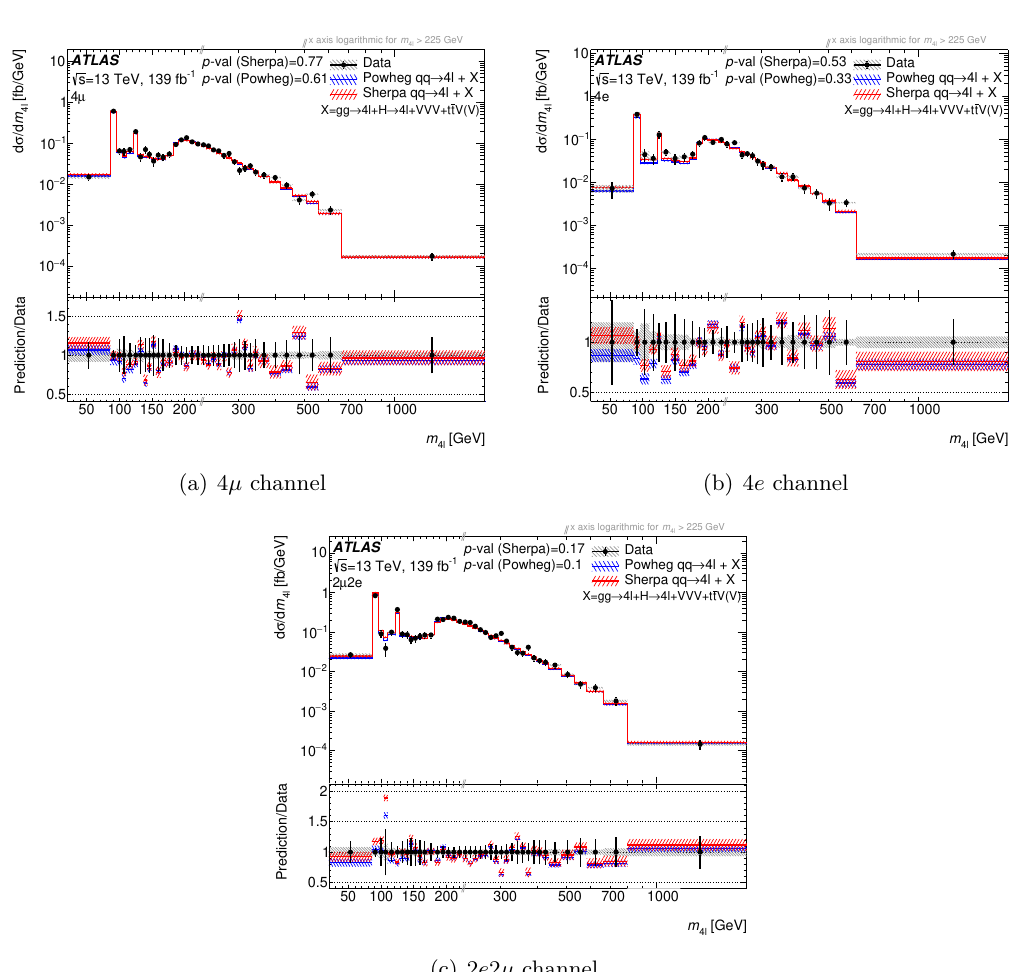
Figure 14 . Differential cross-section as a function of m 4 ‘ for each lepton flavour channel. The measured data (black points) are compared with the SM prediction using either Sherpa (red, with red hashed band for the uncertainty) or Powheg + Pythia8 (blue, with blue hashed band for the uncertainty) to model the q ¯ q → 4 ‘ contribution. The error bars on the data points give the total uncertainty and the grey hashed band gives the systematic uncertainty. The p -value is the probability for the χ 2 , with the number of degrees of freedom equal to the number of bins in the distribution, to have at least the observed value, given the SM prediction. The lower panel shows the ratio of the SM predictions to the data. The x -axis is on a linear scale until m where it switches to a logarithmic